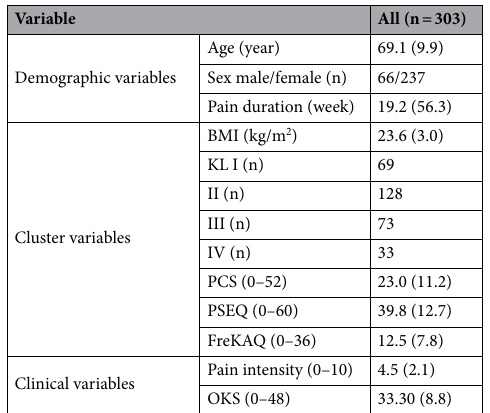
Table 1. Characteristics of this study population. Values are the mean ± SD. BMI body mass index, KL Kellgren/Lawrence, OKS Oxford knee score, PCS pain catastrophizing scale, PSEQ Pain self-efficacy questionnaire, FreKAQ Fremantle knee awareness